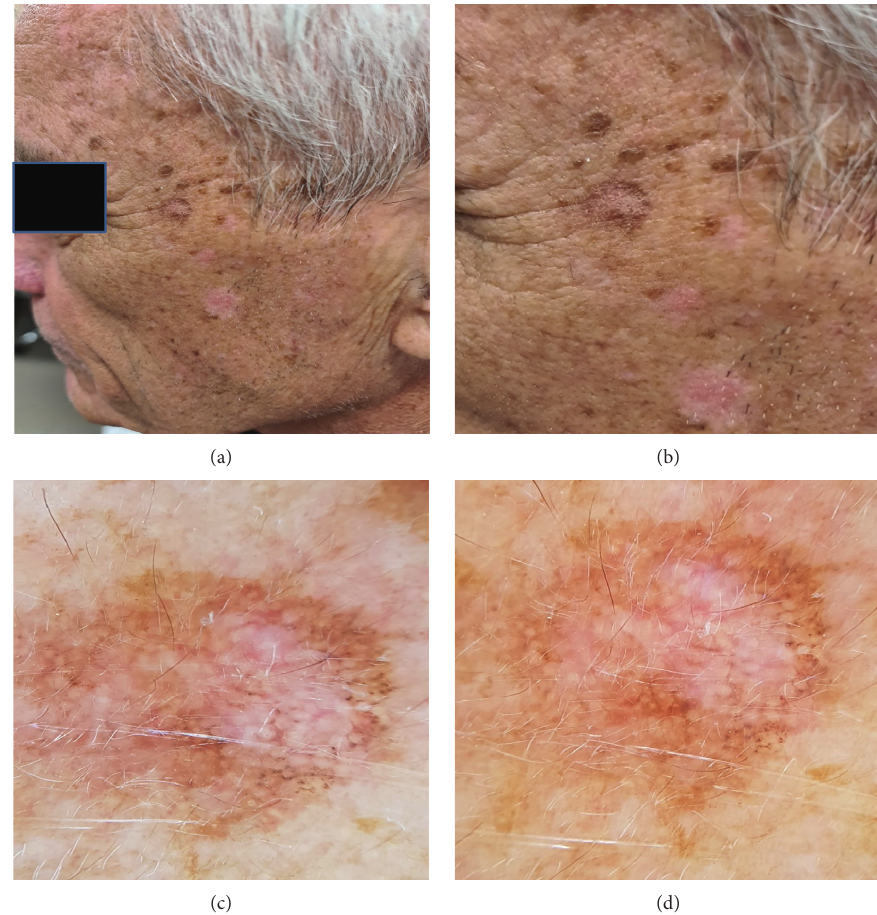
Figure 1: (a, b) Clinical presentation study showed an irregular pigmented flat macule on the left temporal area in the background of ageing skin. (c, d) Dermoscopy showed moth-eaten borders with a faint pigment network and circles within circles. There are irregularly distributed dots from the 3 o’clock to 6 o’clock position. Regression structures in the central area were